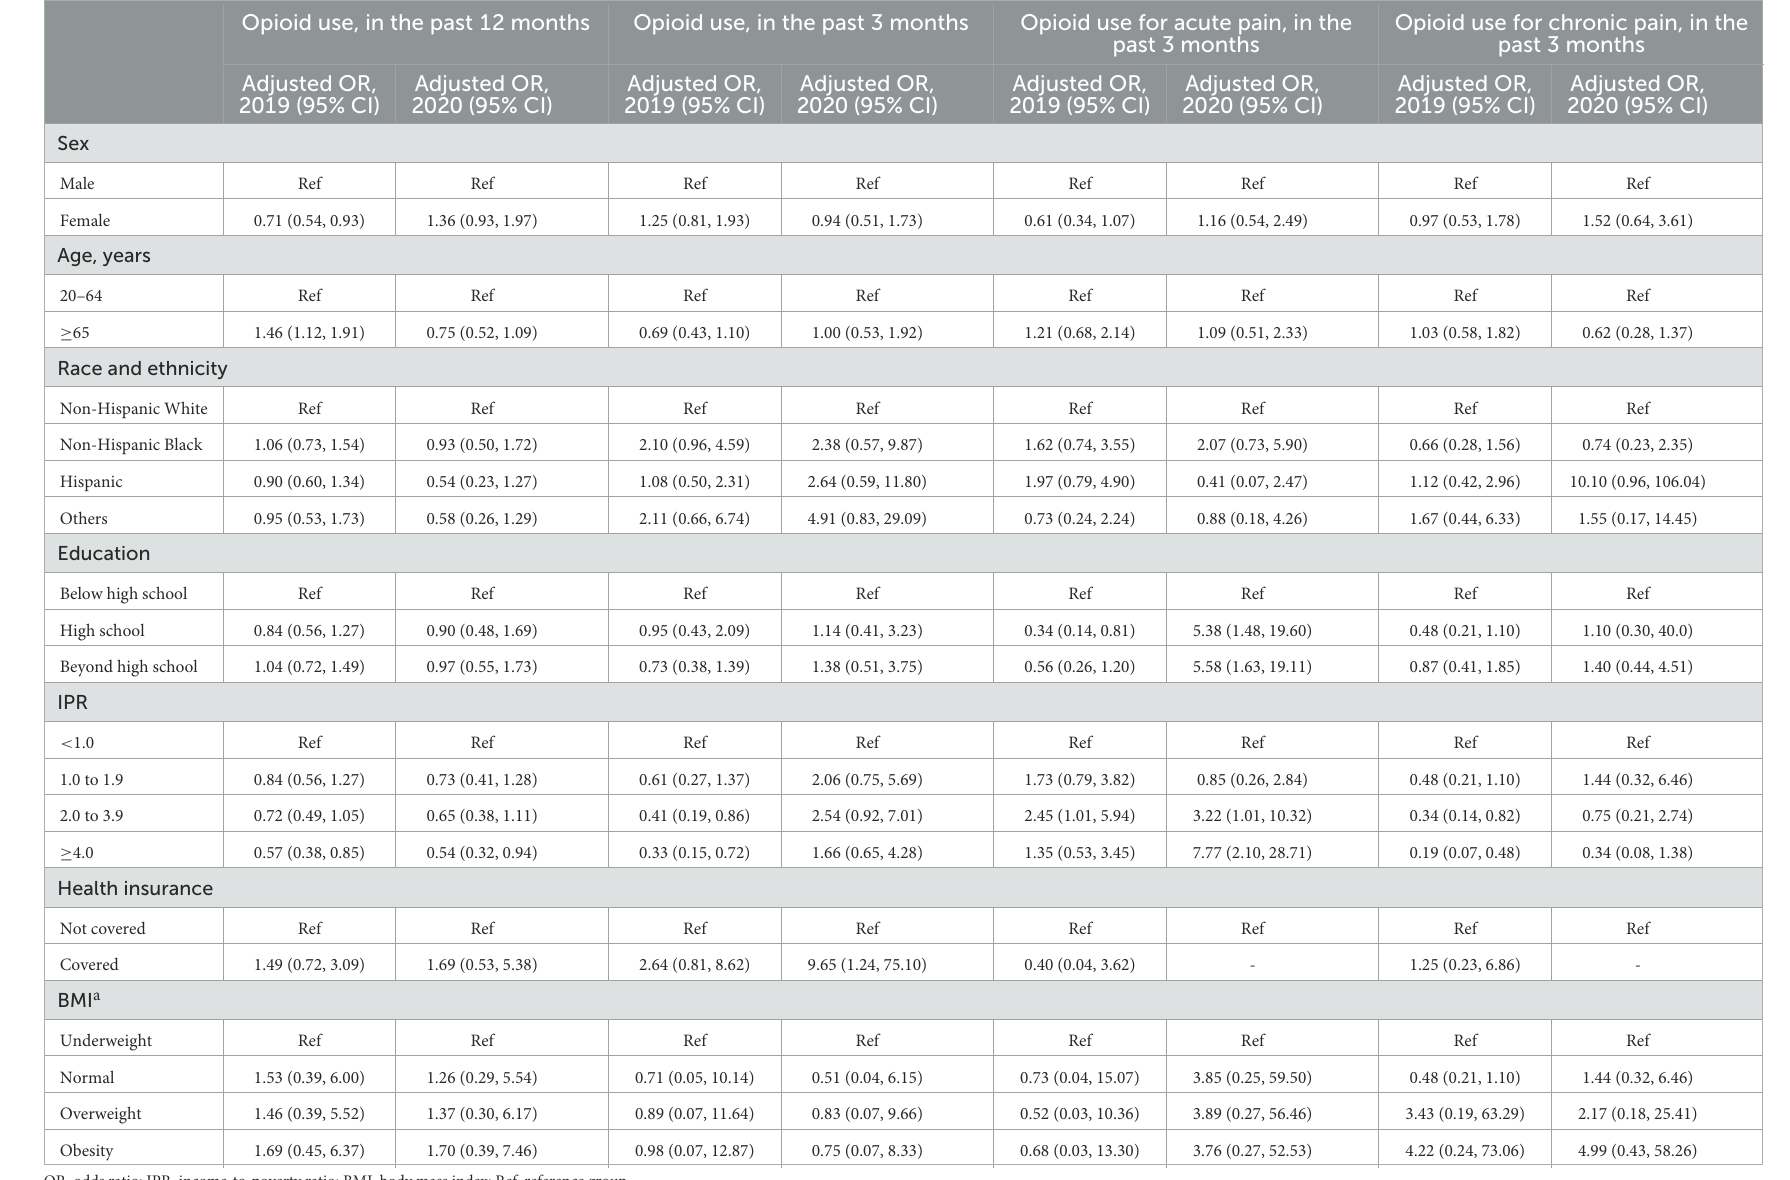
TABLE 3 Adjusted odds ratios of opioid use by subgroup and purpose of use before in 2019 and 2020 among US adults with cardiac conditions aged 20–79